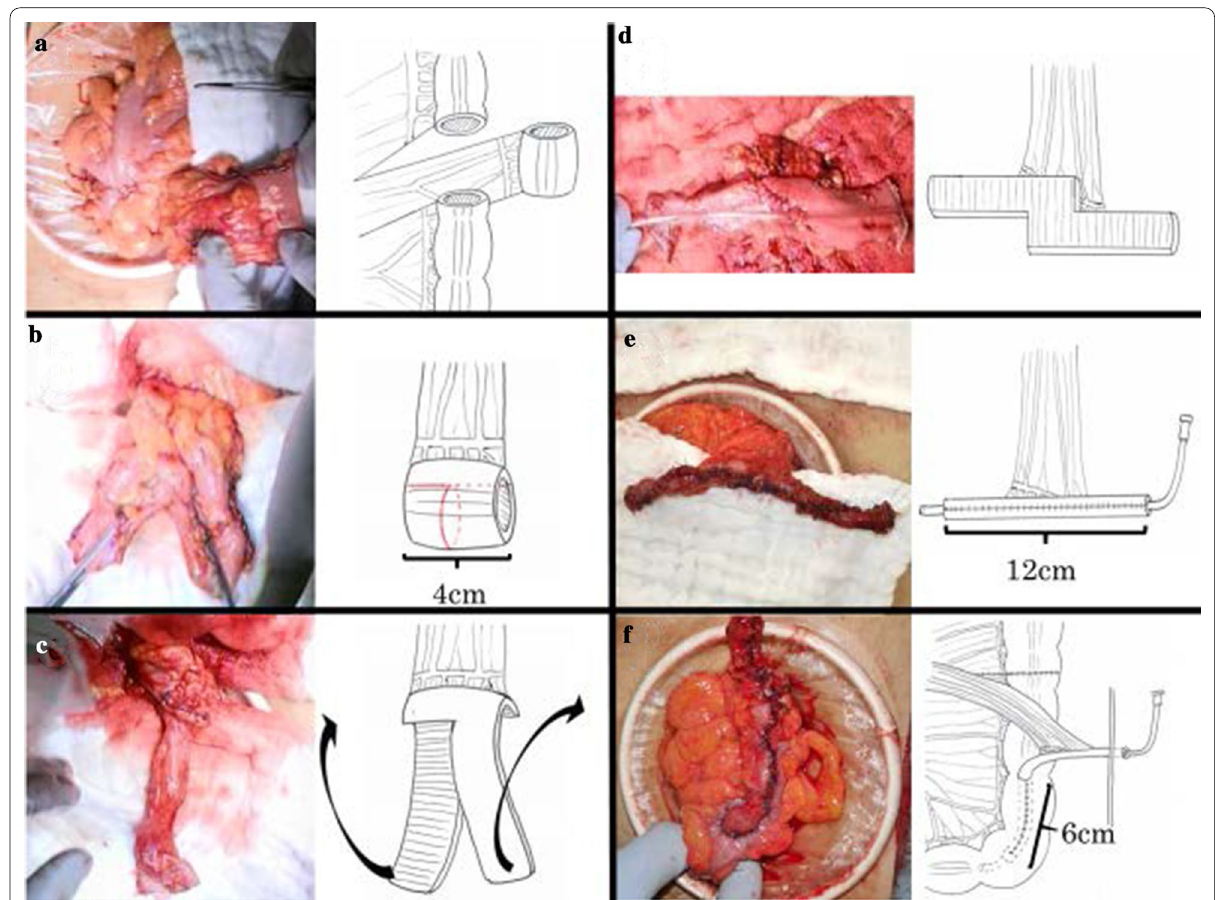
Fig. 2 Monti–Malone procedure. a A 4-cm section of colon was secured while preserving the feeding blood vessels. b – d A two-thirds cut was made in the center of the free intestinal tract. Each left and right intestine was incised longitudinally and widened in a reed-shaped manner. e A 12-cm intestinal tube was created by suturing longitudinally. f The intestinal tube and colon were subjected to end-to-side anastomosis. We used Witzel’s method for coverage of the intestinal tube. The length of that coverage was 6